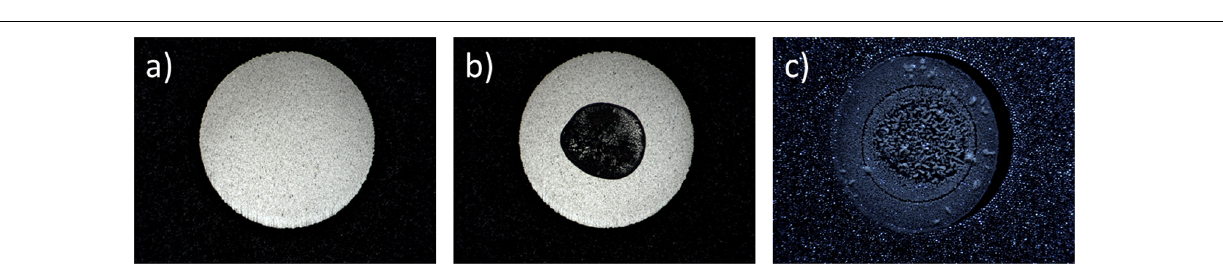
FIGURE 7 | (a) MALDI-TOF MS spot before FW application. (b) Coaxial illumination to control the biomass transfer after FW application of target slide. (c) side Illumination to control the presence of α -cyano-4-hydroxycinnamic acid (CHCA) crystallization with microorganism